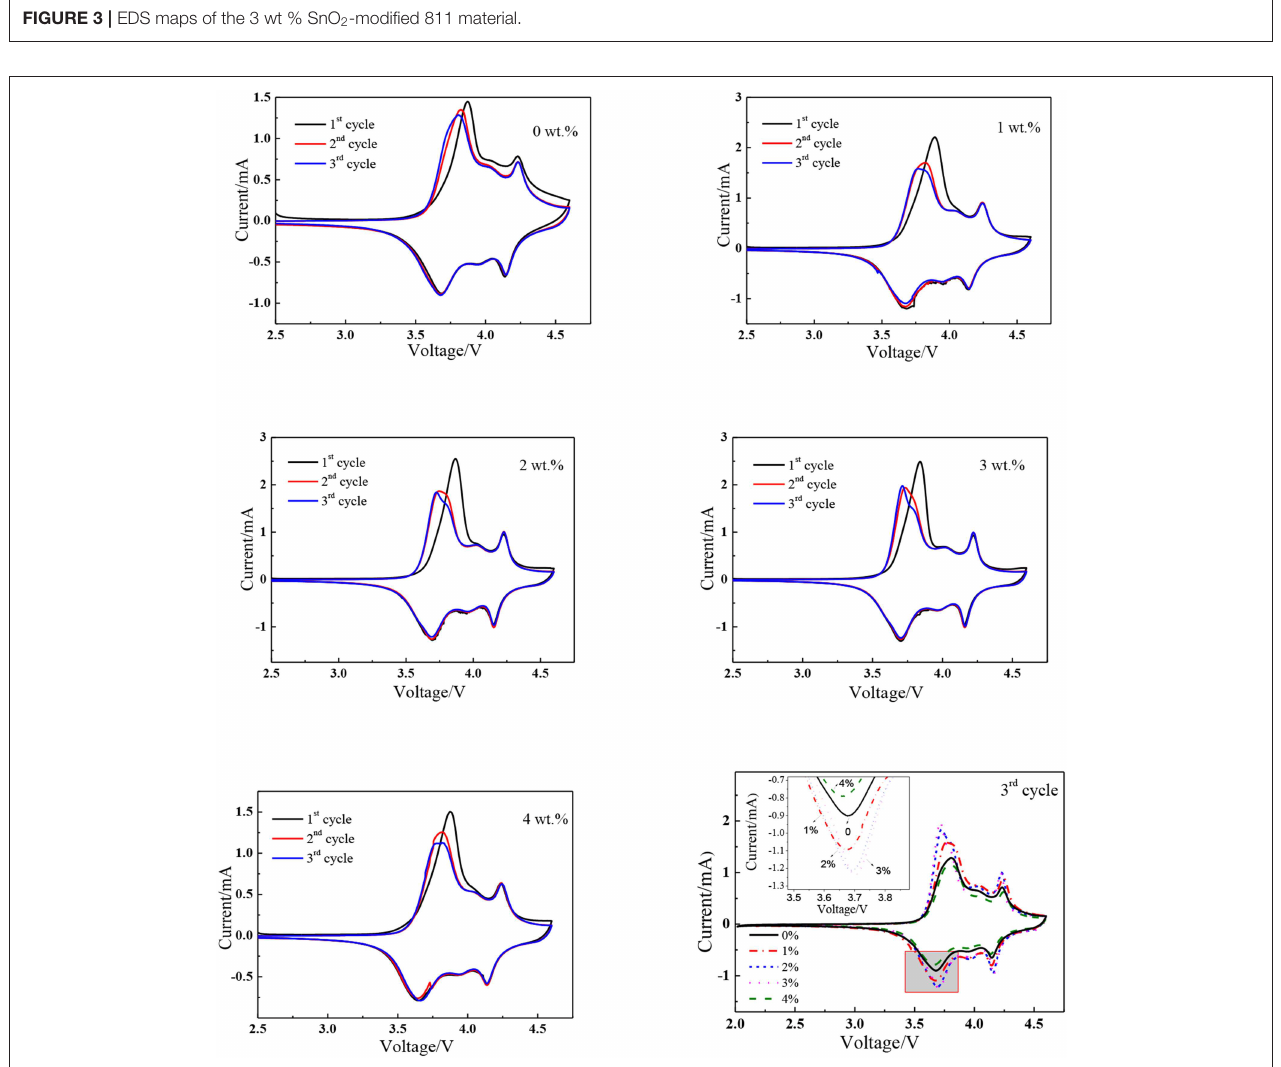
FIGURE 4 | Cyclic voltammograms of pristine and SnO 2 -modified materials.